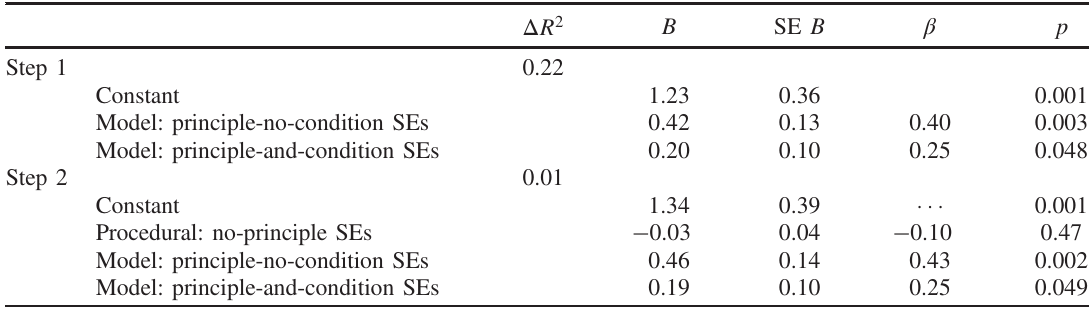
TABLE XIII. Hierarchical regression of aggregated SE categories as predictors of conceptual test score. Note that N ¼ 54